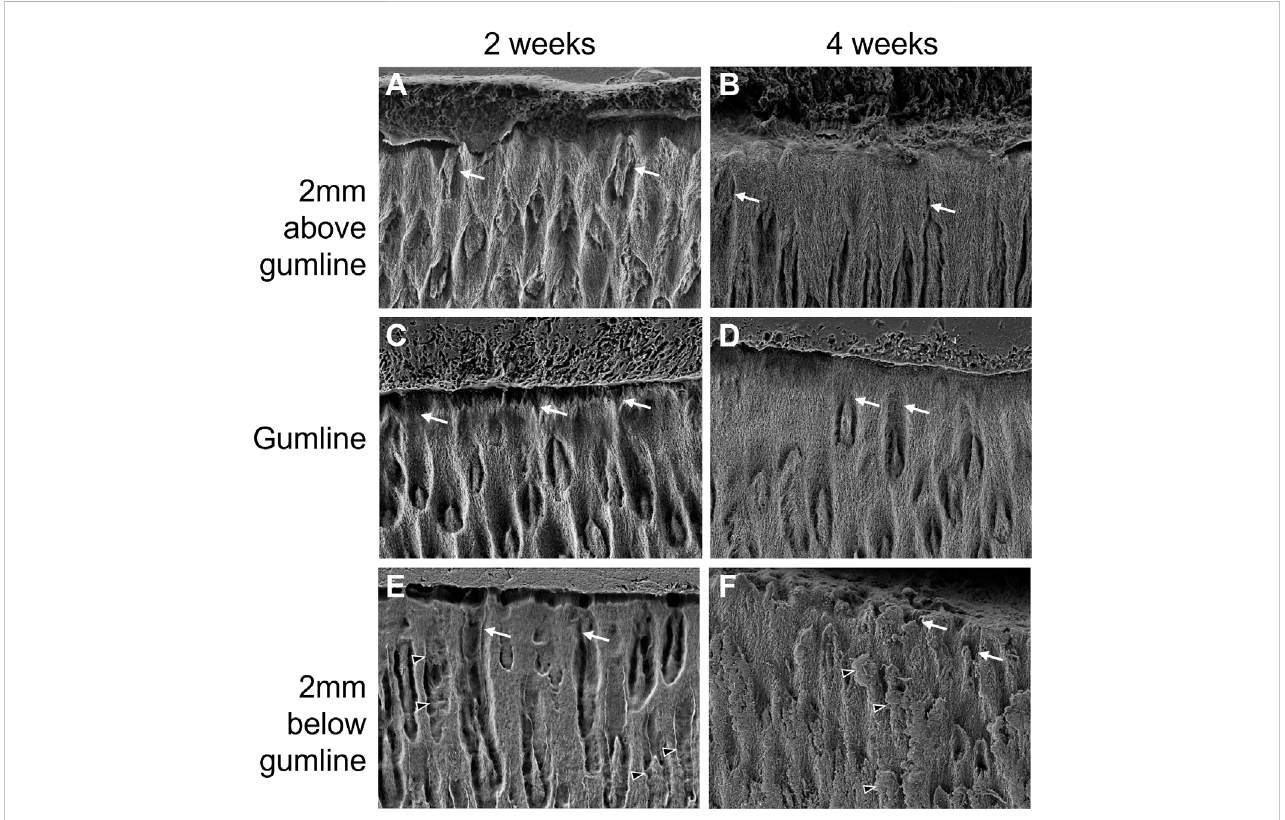
FIGURE 5 Progressionofenamelsurfacemicro-structurewitheruptionandwithageinthe fi rstlowerleftincisorofpigsaged2 weeks (A,C,E) and4 weeks (B,D,F) . (A, B) show surface enamel 2 mm above the gingival eruption level, referred to as gumline, seen in (C, D) , with surface enamel 2 mm below the gumline in (E, F) . Black arrowheads: proteins; white arrows: